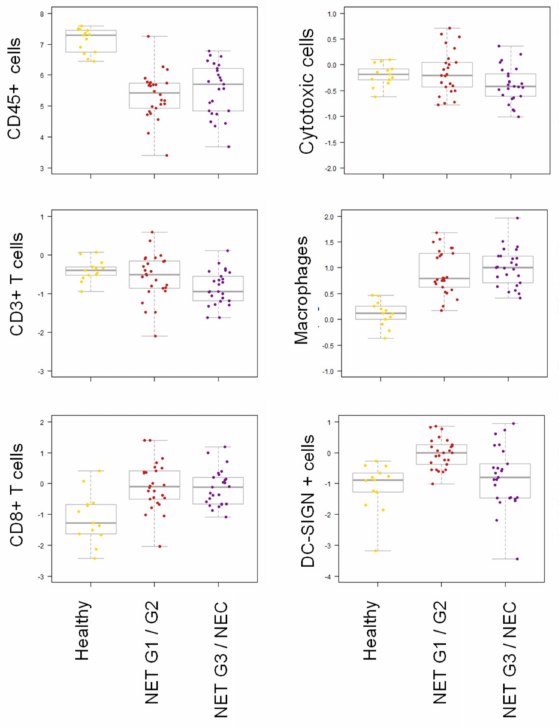
Figure 3. Di ff erential expression of genes associated with cell types in NET G1 / G2 and NET G3 / NEC. Cell scores (cell type / tumor infiltrating immune cells) of di ff erent immune cell subsets were calculated by the expression of mRNA markers specific for each cell type relative to CD45 mRNA levels: T cells, CD3D, CD3E; CD8 + T cells, CD8A; cytotoxic cells, PRF1, KLRK1, KLRB1, GNLY, GMZA; macrophages, CD84, CD163, CD68; DC-SIGN positive cells, CD209 /